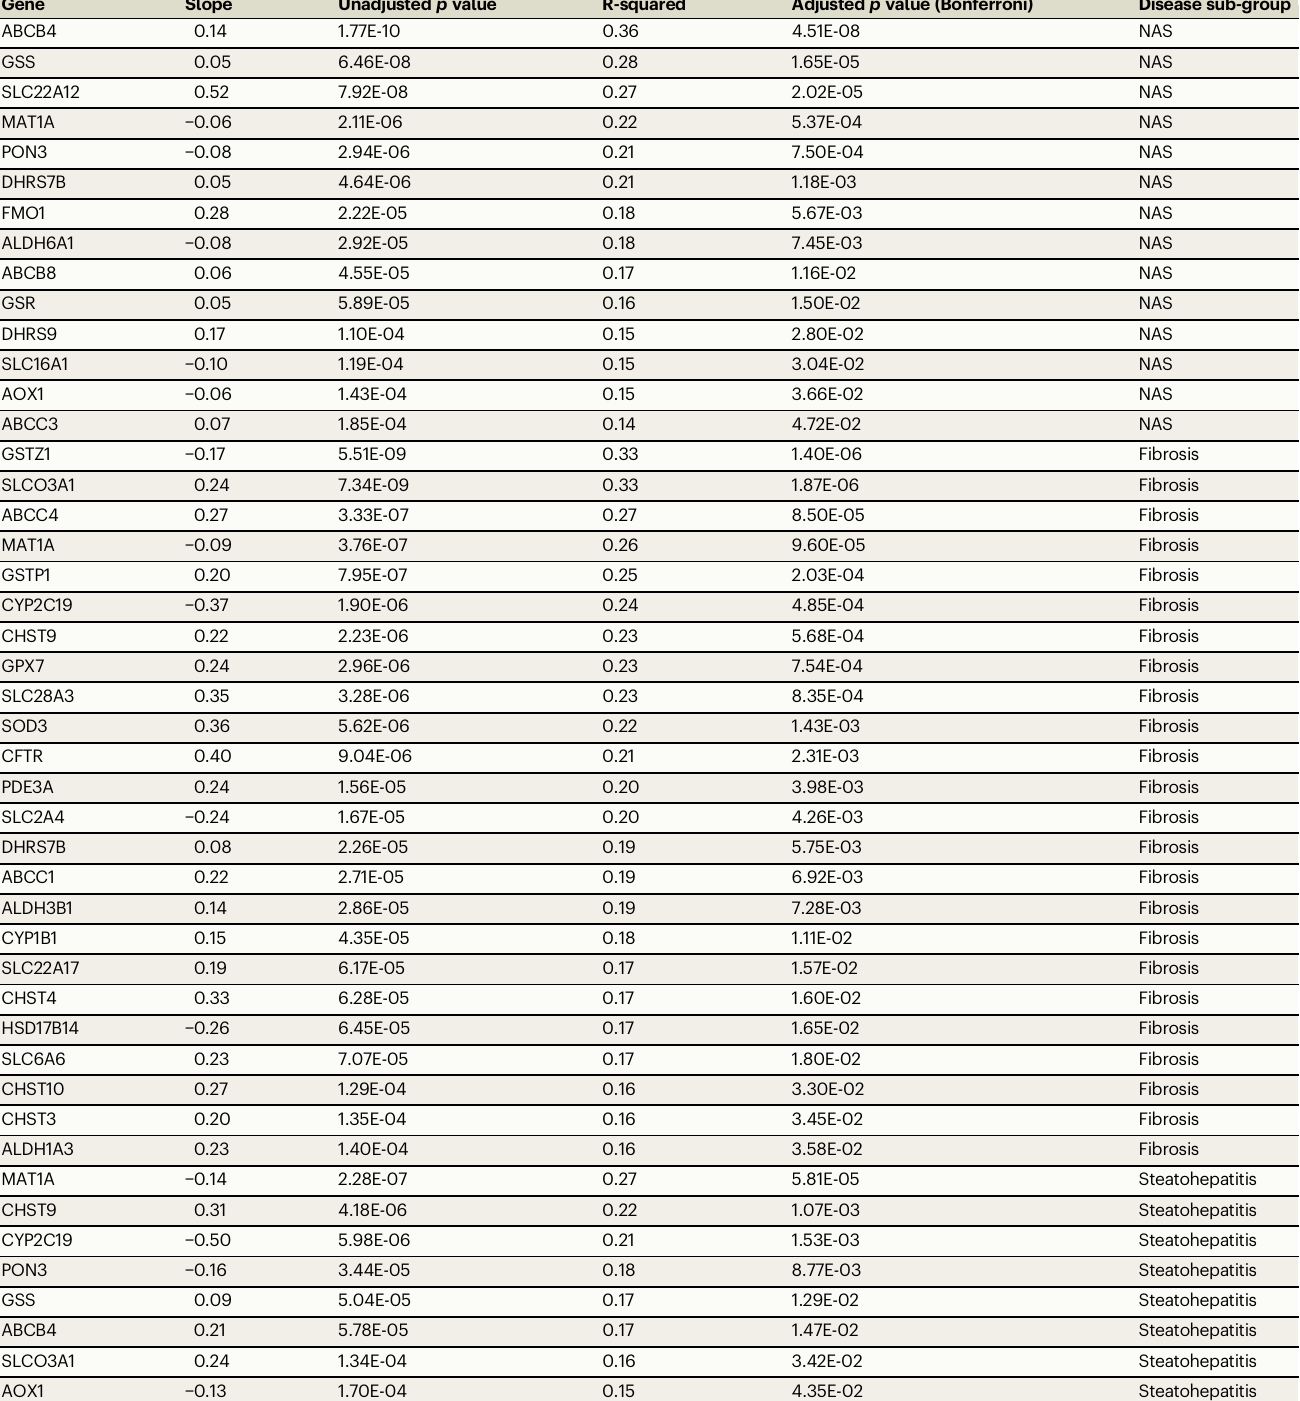
Table 2 | Bonferroni-adjusted signi fi cant linear regression correlation estimates between disease sub-groups and pharmacogenes Gene Slope Unadjusted p value R-squared Adjusted p value (Bonferroni) Disease sub-group